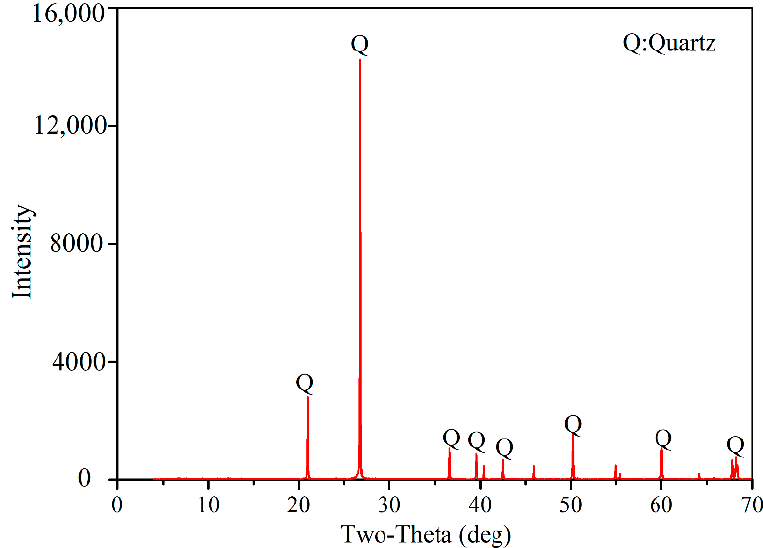
Figure 2. XRD patterns of studied quartz sample.